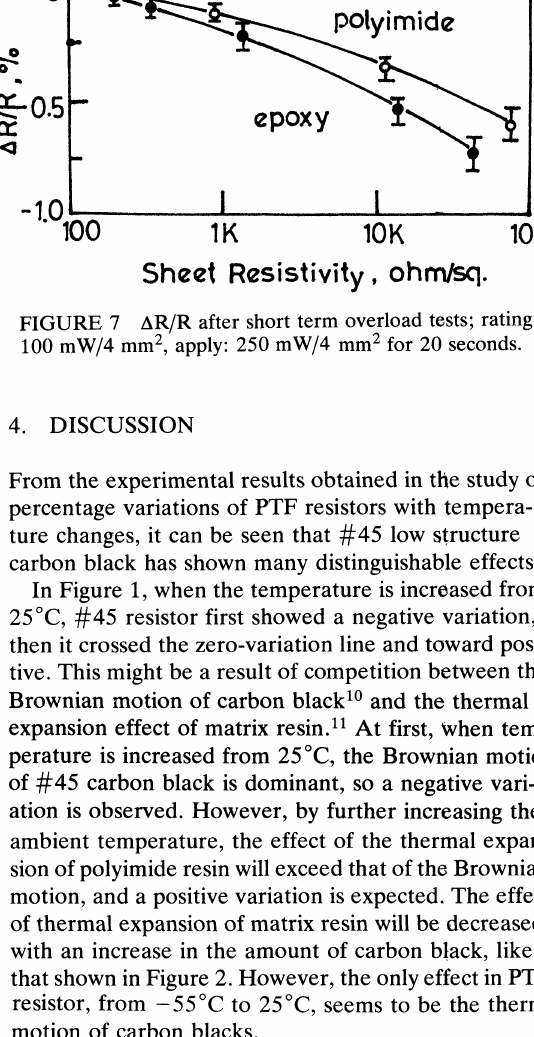
FIGURE 7 zlR/R after short term overload tests; rating: 100 mW/4 mm 2, apply: 250 mW/4 mm for 20 seconds.